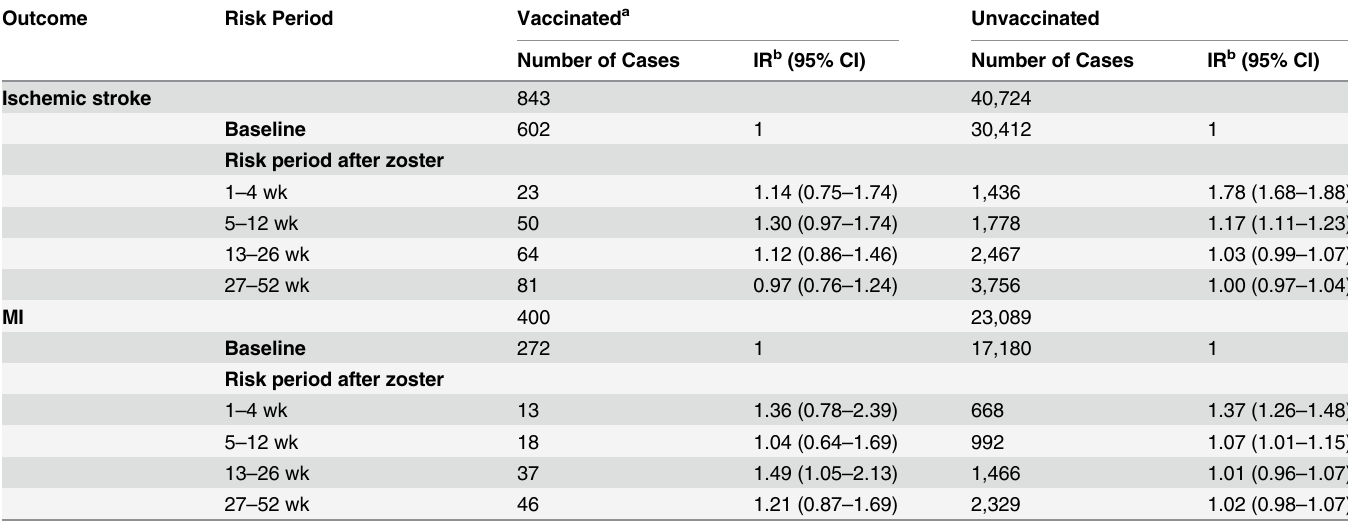
Table 4. Age-adjusted incidence ratios for vascular events in risk periods after zoster diagnosis, stratified by vaccination status. Outcome